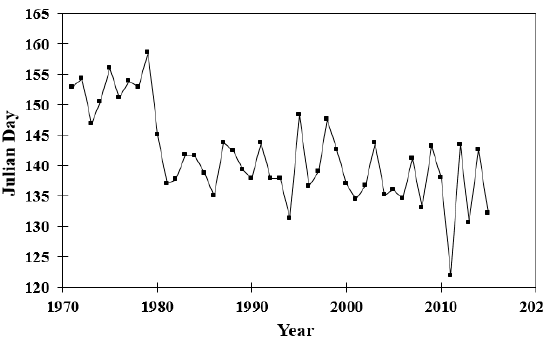
Figure 3. The trend in the rainy season onset on the TP (1971–2015).